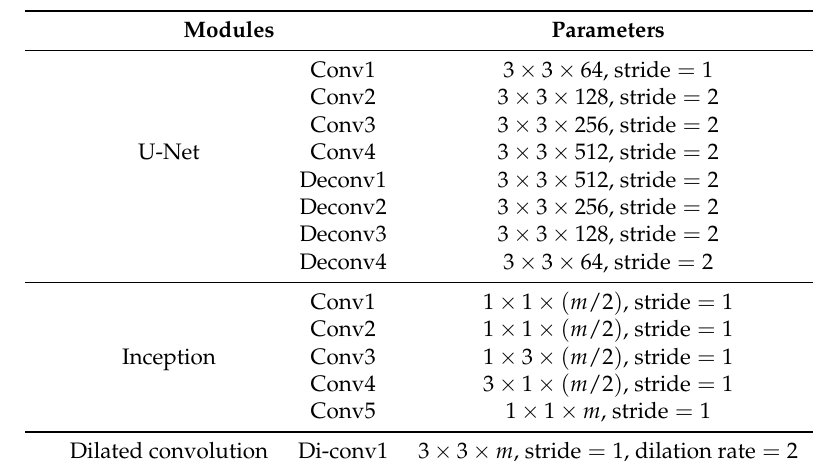
Table 3. Some key parameters in the nodule candidate detection sub-network ( m represents the channels of the former layer)